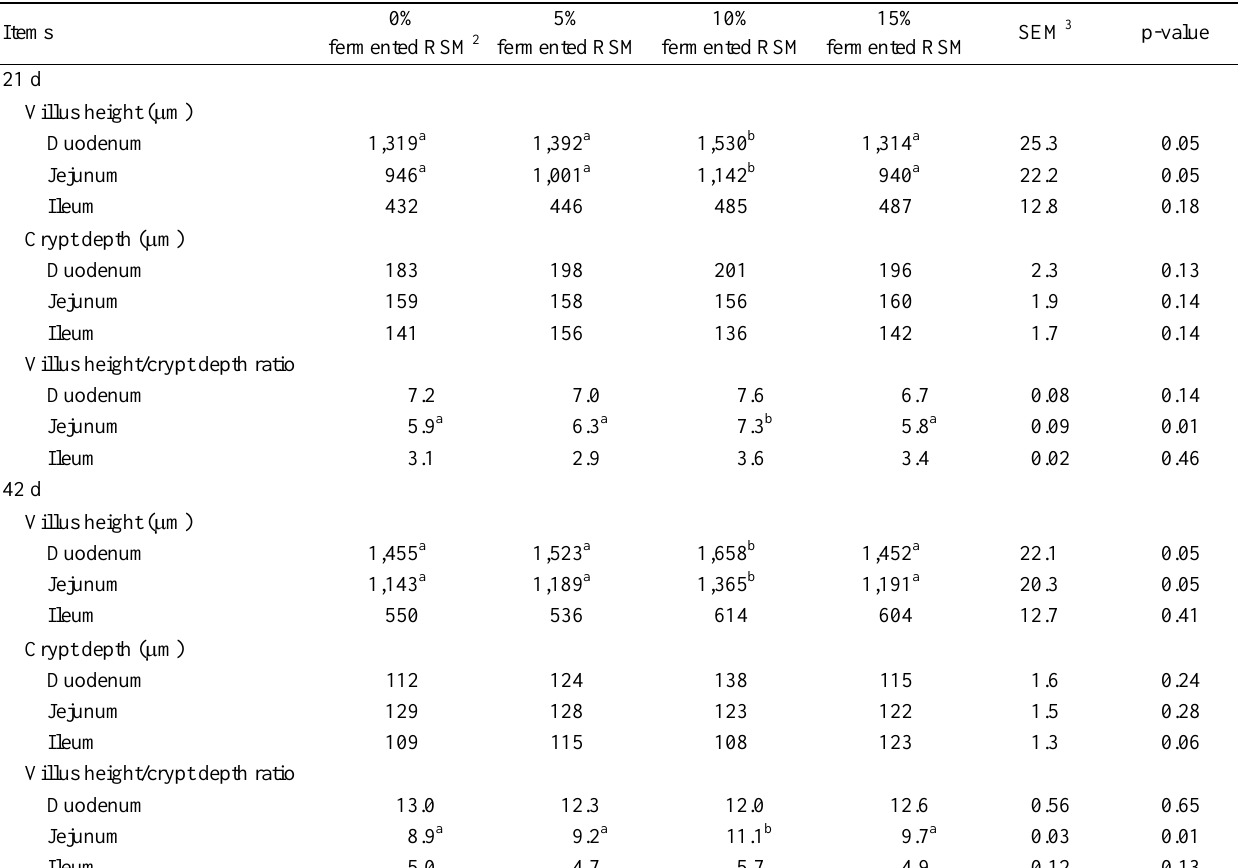
Table 5. Efffects of fermented RSM on small intestinal morphology 1